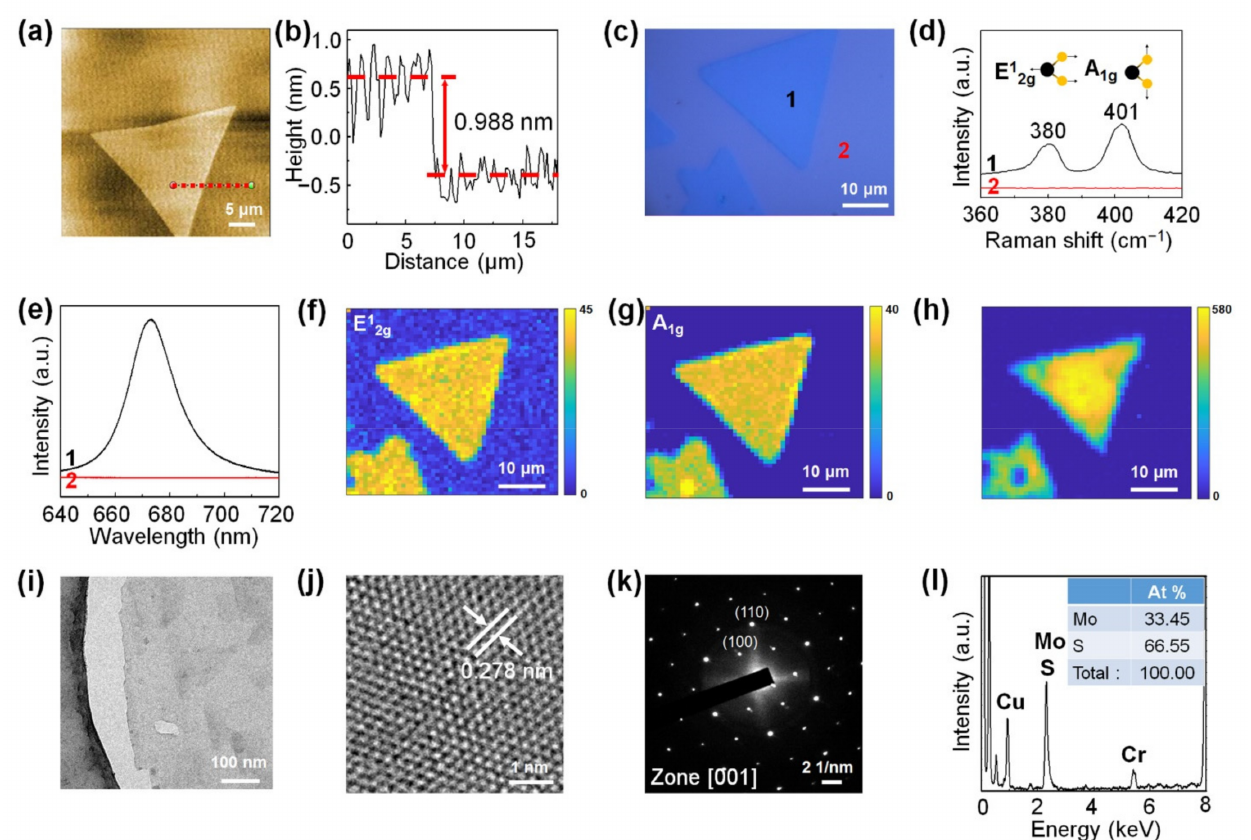
Figure 4. Detailed analysis of monolayer MoS 2 synthesized by CVD growth using carbon cloth. ( a ) AFM image of monolayer MoS 2 . ( b ) Height line profile along the dotted red line in ( a ). ( c ) Optical image of monolayer MoS 2 . ( d ) Raman spectra taken at points 1 and 2 of ( c ). ( e ) PL spectra taken at points 1 and 2 of ( c ). ( f , g ) Raman maps of the E 2g mode and A 1g mode of MoS 2 , respectively. ( h ) PL map of monolayer MoS 2 . ( i ) Low-magnification transmission electron microscopy (TEM) image of monolayer MoS 2 . ( j ) High-resolution TEM (HRTEM) image of monolayer MoS 2 . ( k ) Selected area electron diffraction (SAED) patterns of monolayer MoS 2 . ( l ) TEM–energy-dispersive X-ray spectroscopy (TEM–EDS) data of monolayer MoS 2